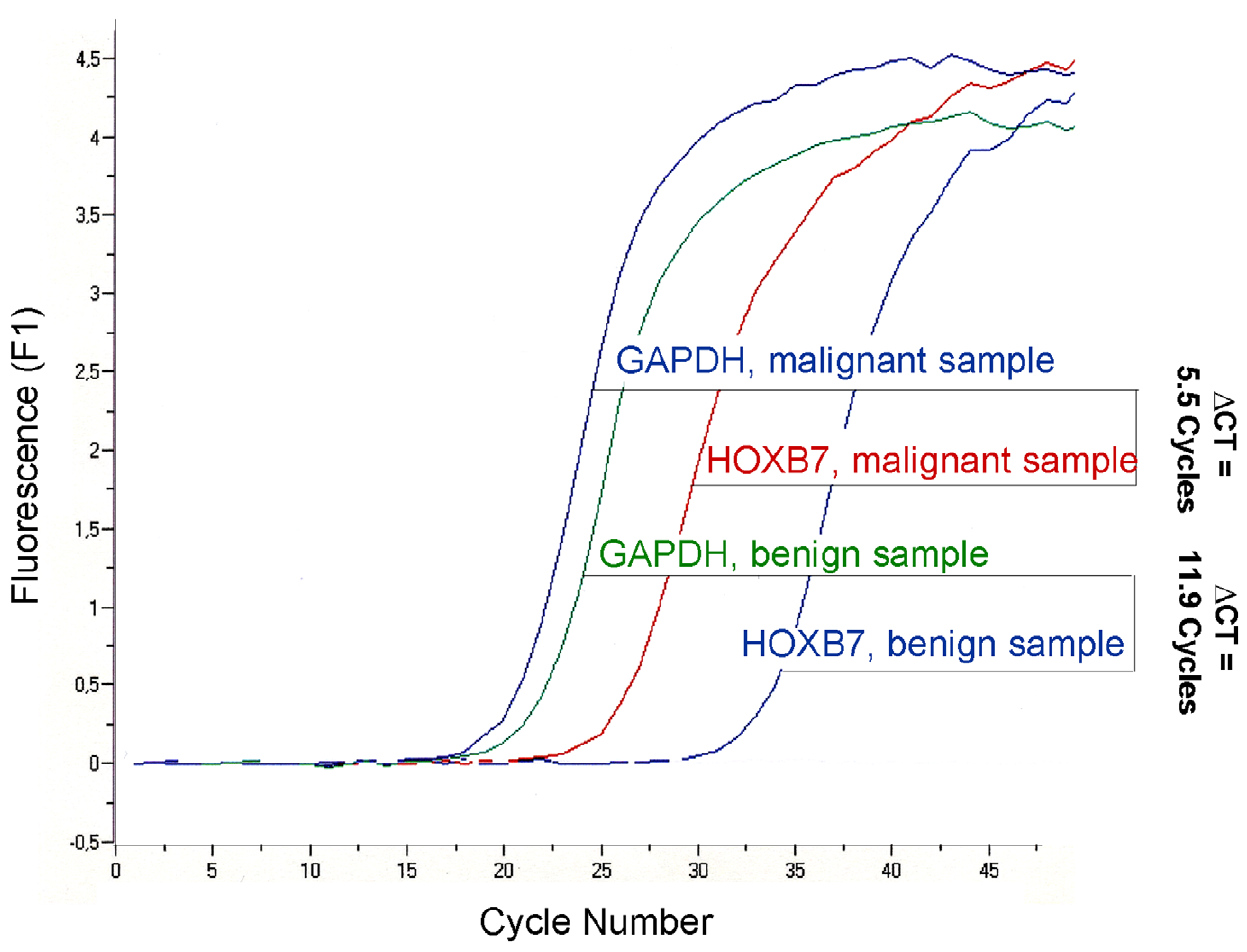
Figure 1. Amplification curve analysis of a representative benign and malignant sample, respectively.